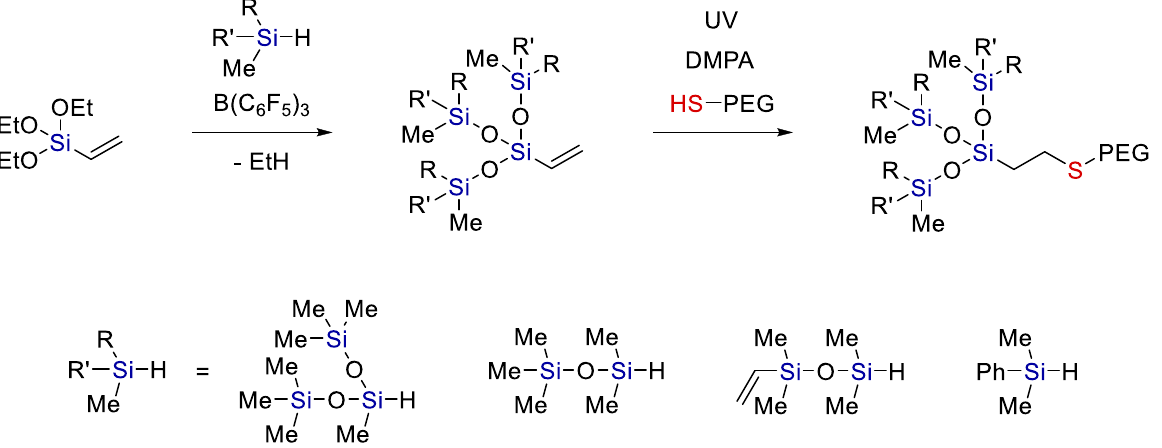
Figure 12. A scheme of consecutive Piers – Rubinsztajn and thiol-ene addition reactions [40]. Adopted from Ref.